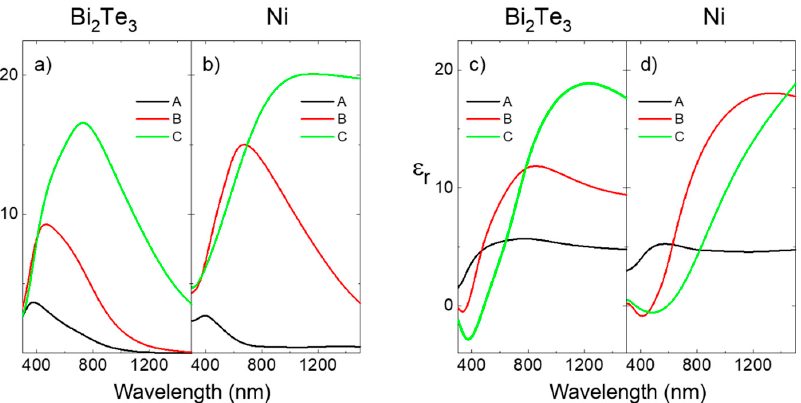
Figure 4. Experimental spectra of the imaginary part ( a , b ) and real part ( c , d ) of the in-plane effective dielectric constant of 1D nanowire arrays with 100 nm inter-wire distance (black line, labeled A), 1D nanowire arrays with 65 nm inter-wire distance (red line, labeled B) and 3D nanowire network (green curve, labeled C) made of Bi 2 Te 3. ( a , c ) and Ni ( b , d ).